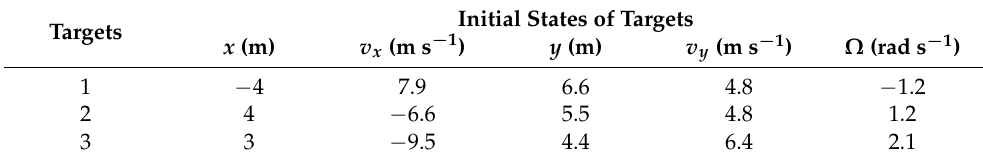
Figure 5. The radar and targets geometry for scenario 1. Table 1. Scenario